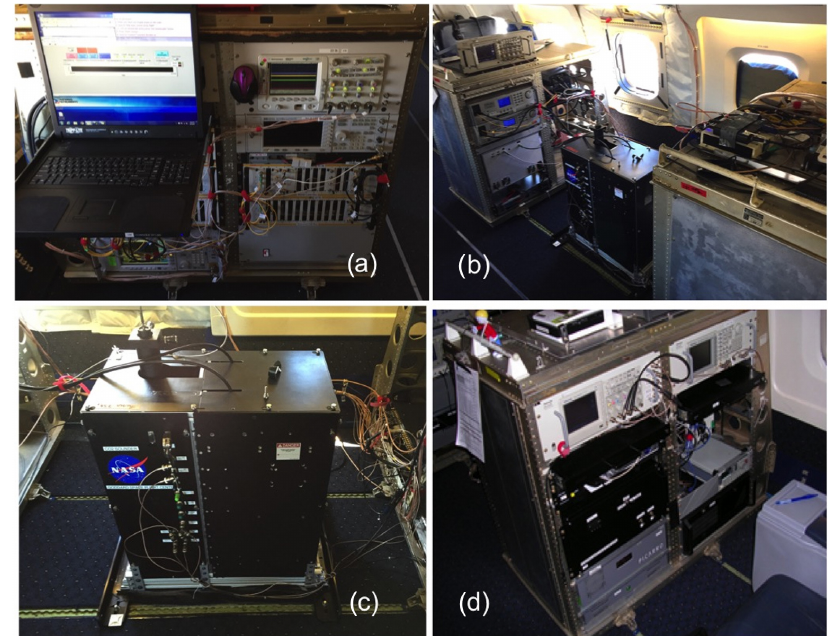
Figure 1. CO 2 Sounder instrument photographs. (a) The aircraft rack with the new seed laser subsystem. (b) The aircraft racks containing the laser power amplifiers and the lidar’s detector subsystem. (c) The lidar’s transmitter and receiver telescope assembly, which is positioned over the nadir window assembly in the aircraft fuselage. The laser pulses from the fiber amplifiers and the received optical signals are coupled via fiber optics. (d) The instrument operator’s console, with the control computer screens folded away.